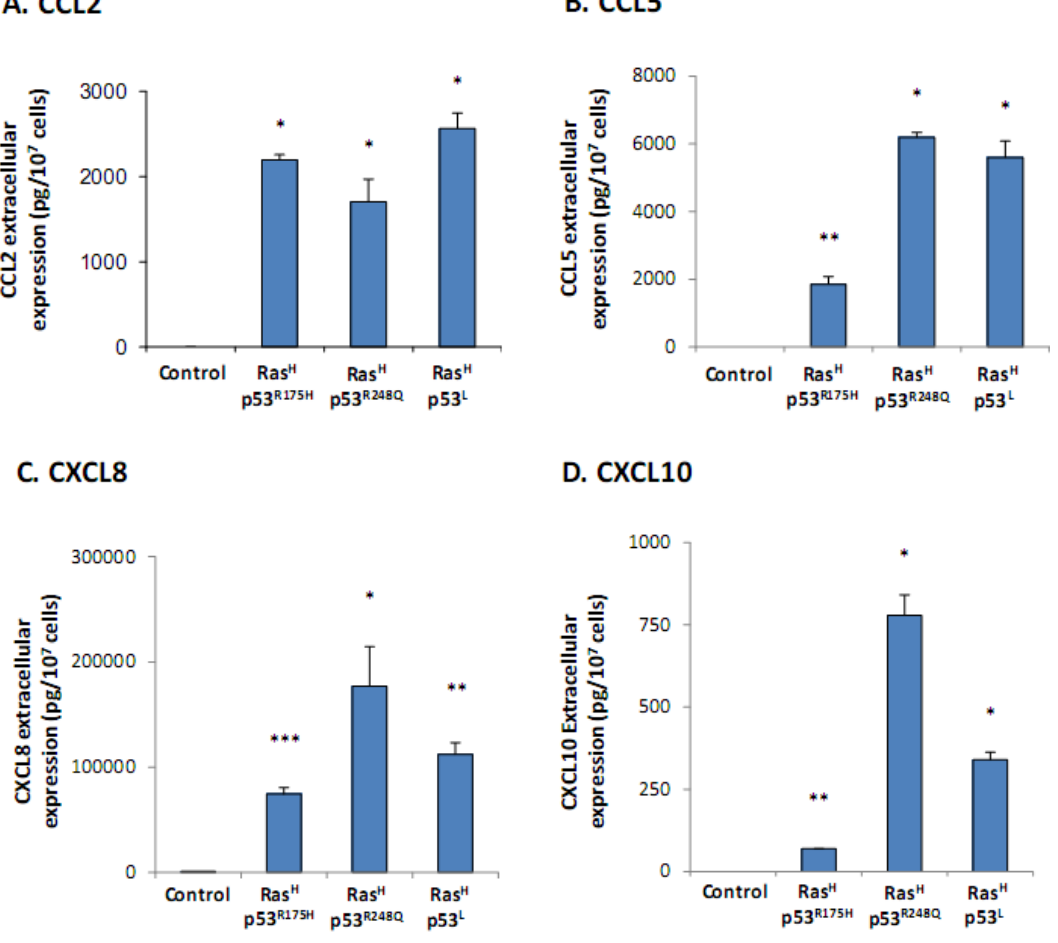
Figure 1. The release of the cancer-related chemokine cluster is up-regulated in non-transformed cells modified to express oncogenic Ras and dysfunctional p53. WI-38 human fibroblasts were modified to express oncogenic Ras and dysfunctional p53, together. These cells were kept in culture, and chemokine expression was determined in their supernatants by sandwich ELISA assays, at the linear range of absorbance. ( A )